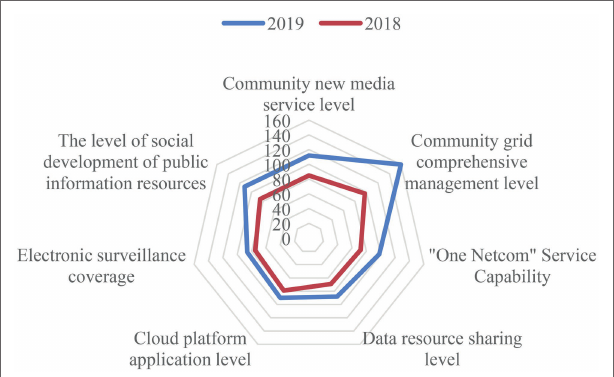
FIGURE 4 | Big data community governance indicator value radar chart.